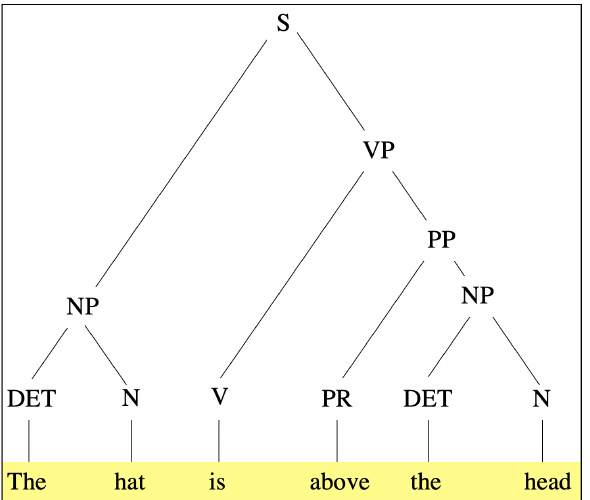
Figure 2. Production rules for the example “The hat is above the head” visualized as Phrase-Structure tree